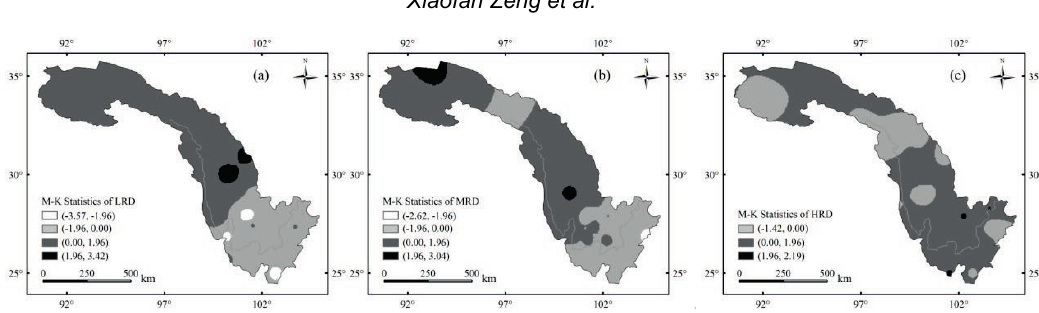
Fig. 7 Spatial changes of M-K statistics of rainy days during 1961–2010: (a) LRD, (b) MRD, (c) HRD.